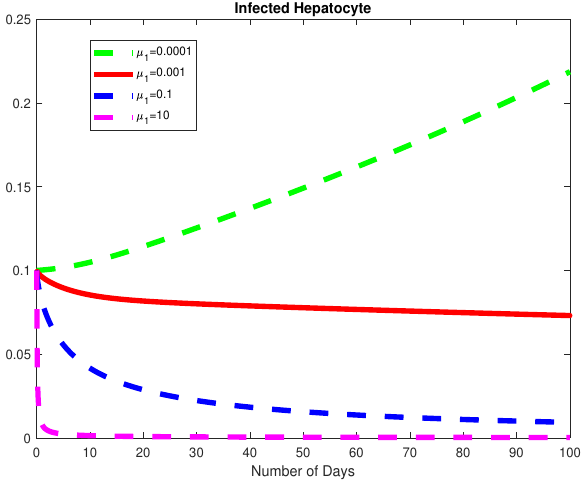
Figure 15. The dynamics of the Infected Hepatocytes ( I ) for varying values of µ 1